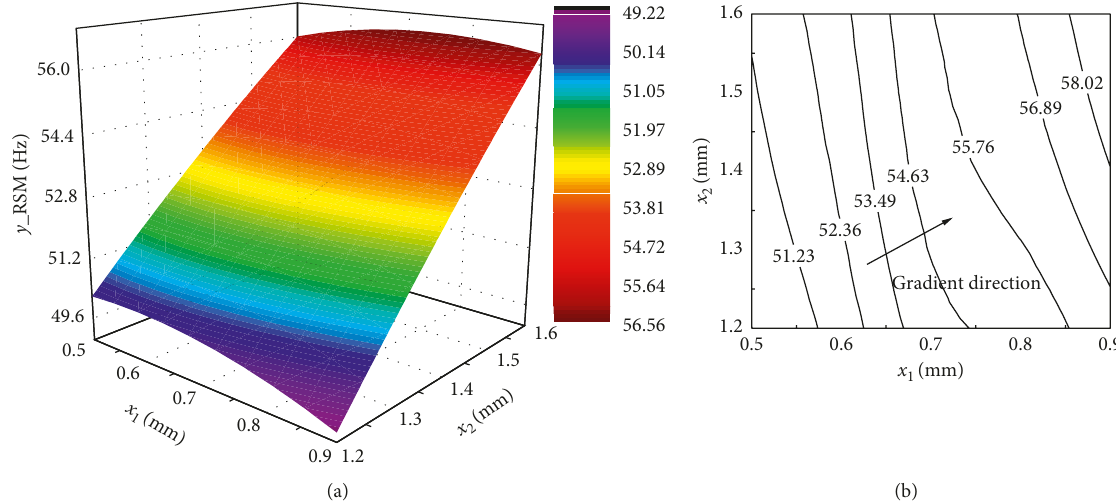
Figure 4: Modal frequency responses with respect to design factors x of modal frequency.